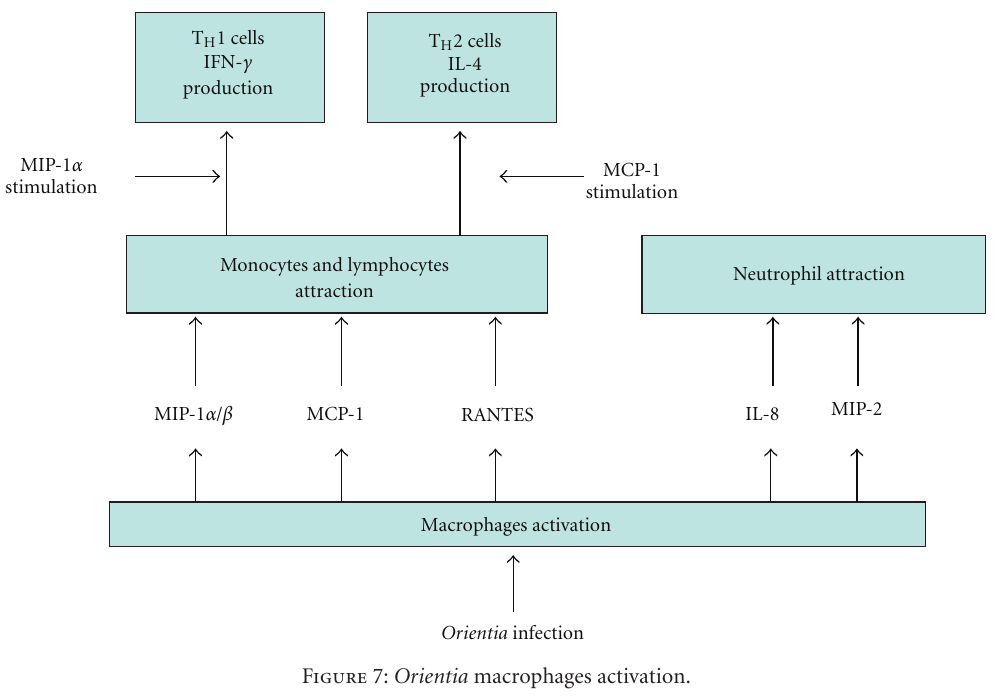
Figure 7: Orientia macrophages activation.